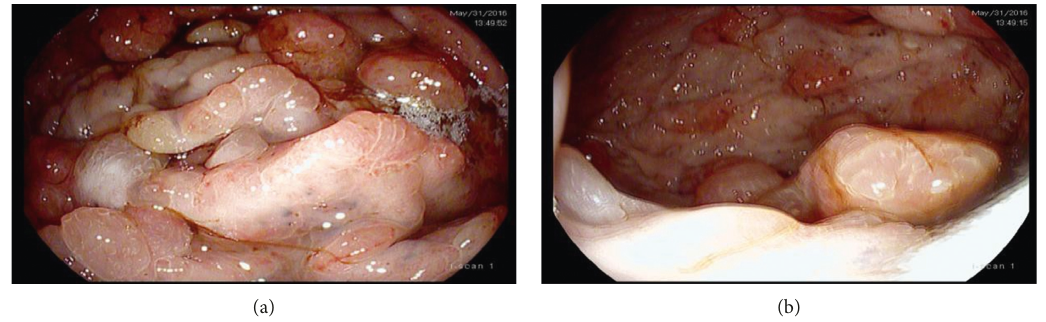
Figure 4: Endoscopic findings of the upper gastrointestinal tract at the initial diagnosis. (a) The stomach revealing mucosal edema and hypertrophic gastric villi and (b) multiple semipedunculated gastric